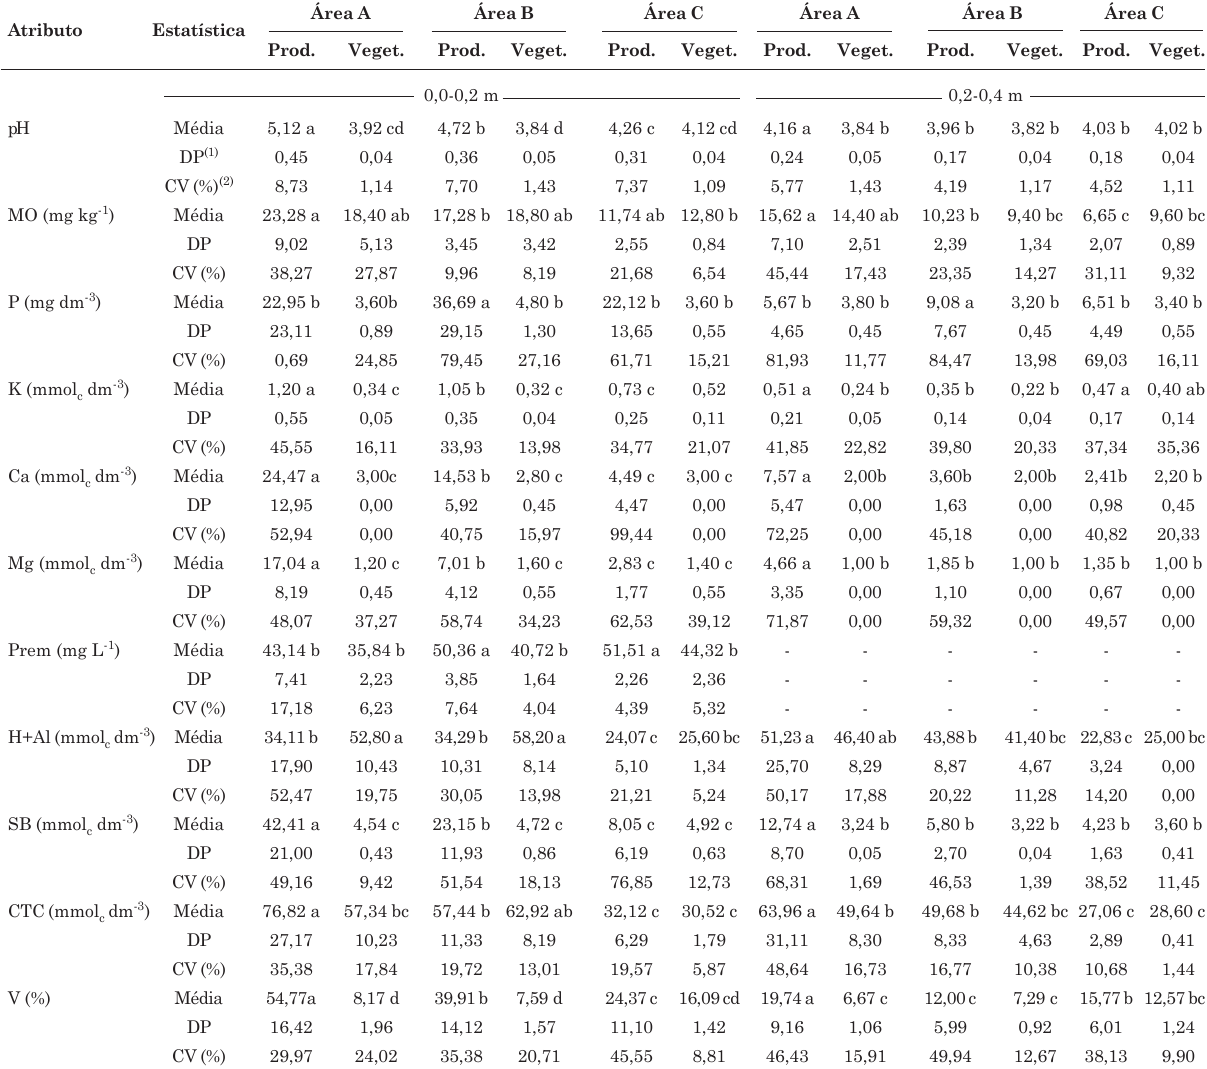
Quadro 2. Valores médios dos atributos químicos dos solos estudados nas profundidades de 0,0-0,2 e de 0,2-0,4